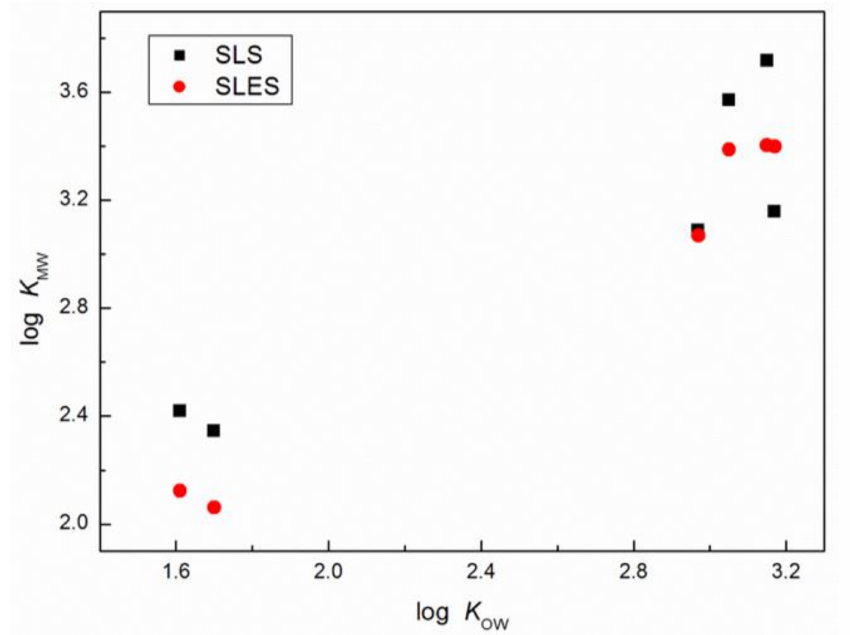
Figure 5. The values of log log K MW vs. log K OW for the studied fragrance materials and anionic